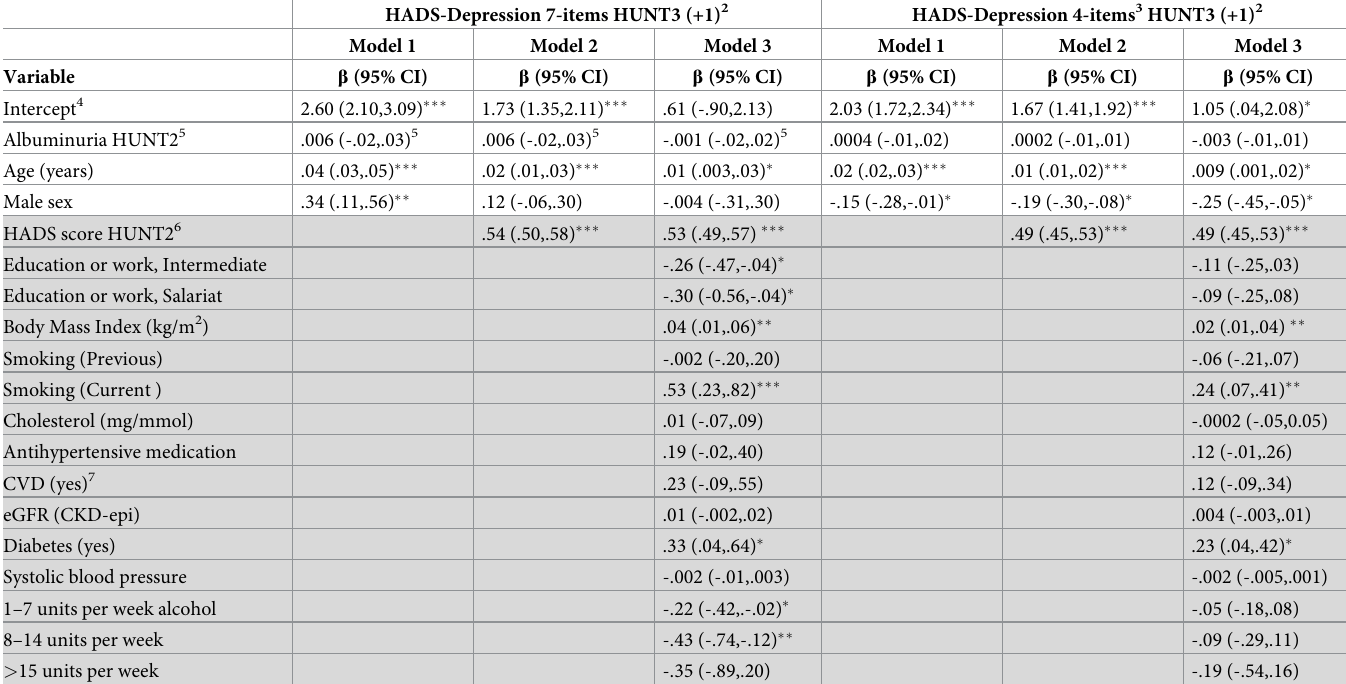
Table 3. General linear regression 1 of the effects of albuminuria in HUNT2 on depression symptoms in